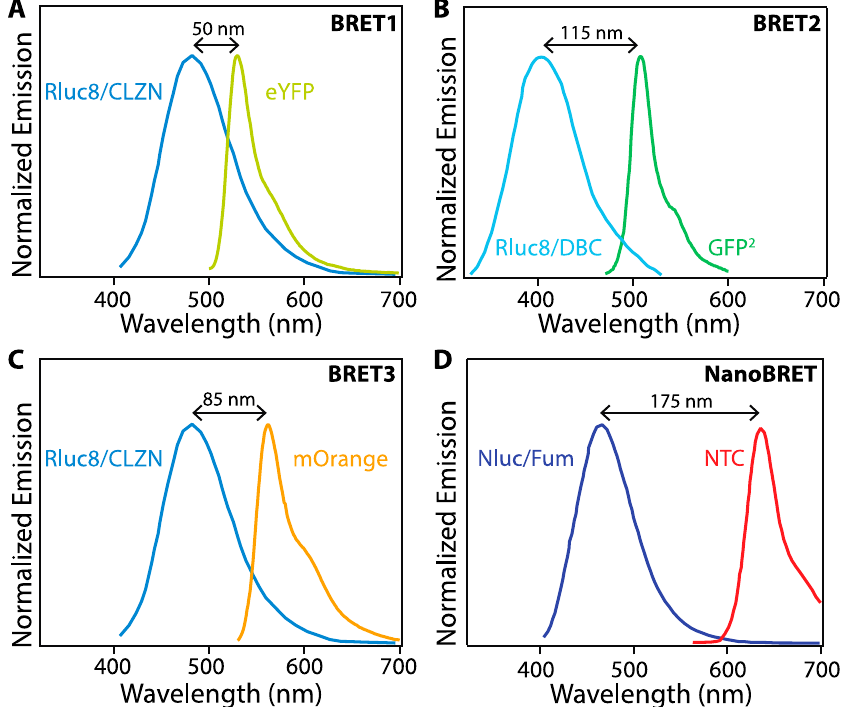
Figure 3. Comparison between different BRET systems. ( A ) BRET1 with Rluc8 mutant of Rluc as BRET donor and enhanced yellow fluorescent protein (eYFP) as BRET acceptor. ( B ) BRET2 with Rluc8 coupled with the substrate DeepBlueC (DBC) as the BRET donor and a green fluorescent protein variant (GFP 2 ) as the BRET acceptor. ( C ) BRET3 using Rluc8/mOrange BRET-pair with coelenterazine as the substrate. ( D ) NanoBRET uses Nluc with a novel coelenterazine derivative, furimazine, and a chloroalkane derivative of nonchloro TOM (NCT) dye, which covalently binds to a HALO tag fused to Nluc. Adapted from [19,36].